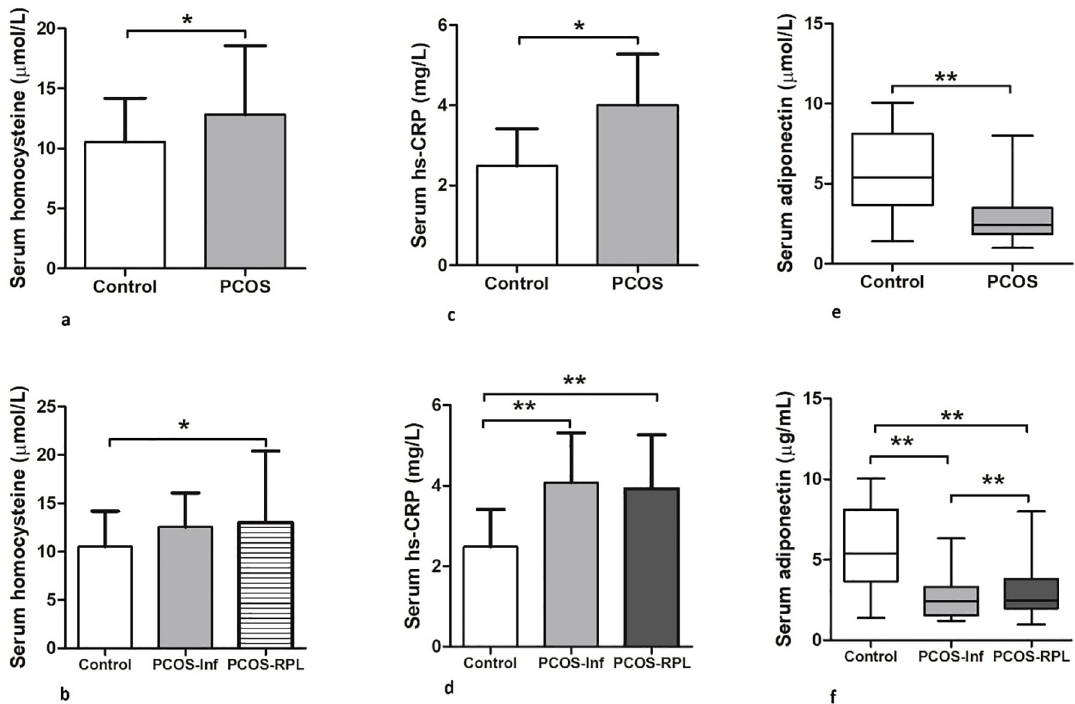
Fig 1. Serum levels of cardiovascular biomarkers and adiponectin. (a) Comparison of serum levels of homocysteine ( μ mol/L) in control vs. PCOS group (P < 0.05), and (b) control vs. PCOS-Inf vs. PCOS-RPL subgroups (P < 0.05). (c) Comparison of serum levels of hs-CRP (mg/L) in control vs. PCOS group (P < 0.05), and (d) control vs. PCOS-Inf vs. PCOS-RPL subgroups (P < 0.001). (e) Comparison of serum levels of adiponectin ( μ mol/L) in control vs. PCOS group (P < 0.001), and (f) control vs. PCOS-Inf vs. PCOS-RPL subgroups (P < 0.001). PCOS : Polycystic ovary syndrome; PCOS-Inf : Infertile PCOS; RPL : Recurrent pregnancy loss; hs-CRP : high sensitivity C-reactive protein .